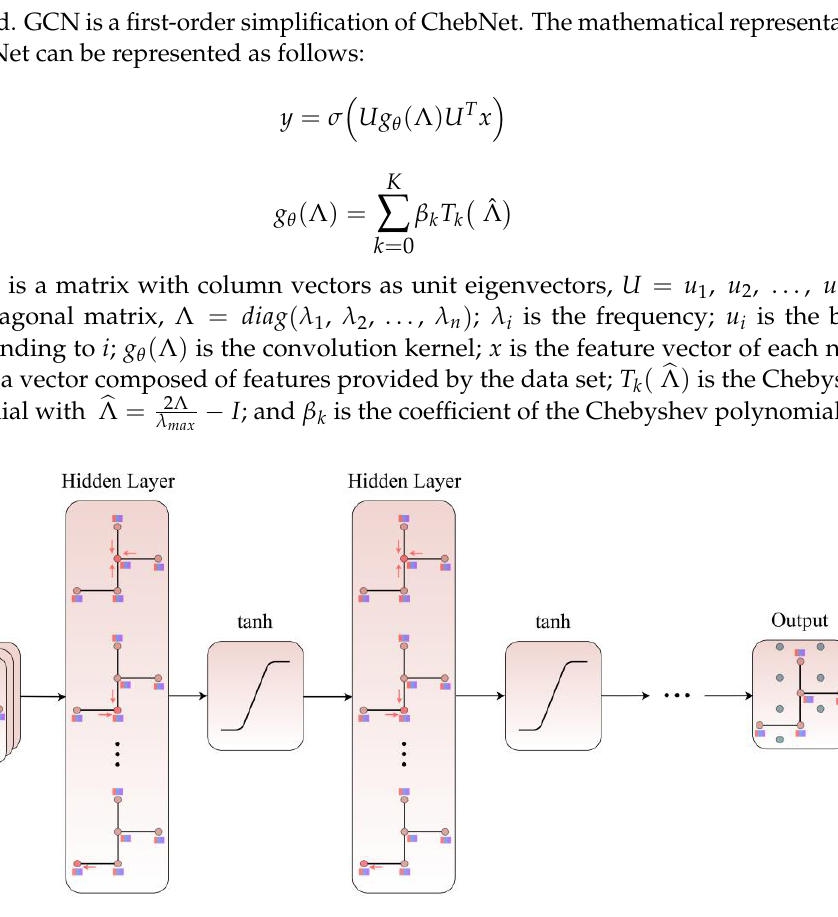
Figure 1. The architecture of the GCN model.